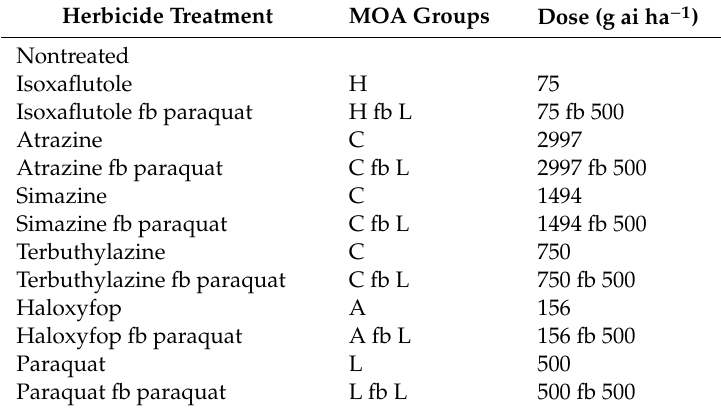
Table 2. Herbicide treatments, mode of action (MOA) herbicide group and herbicide dose used in sequential application